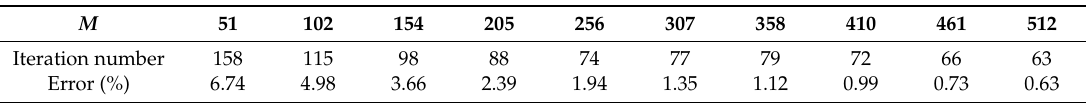
Table 1. The relations of M with the reconstruction error and the computation complexity during the reconstruction of gas mutation data.